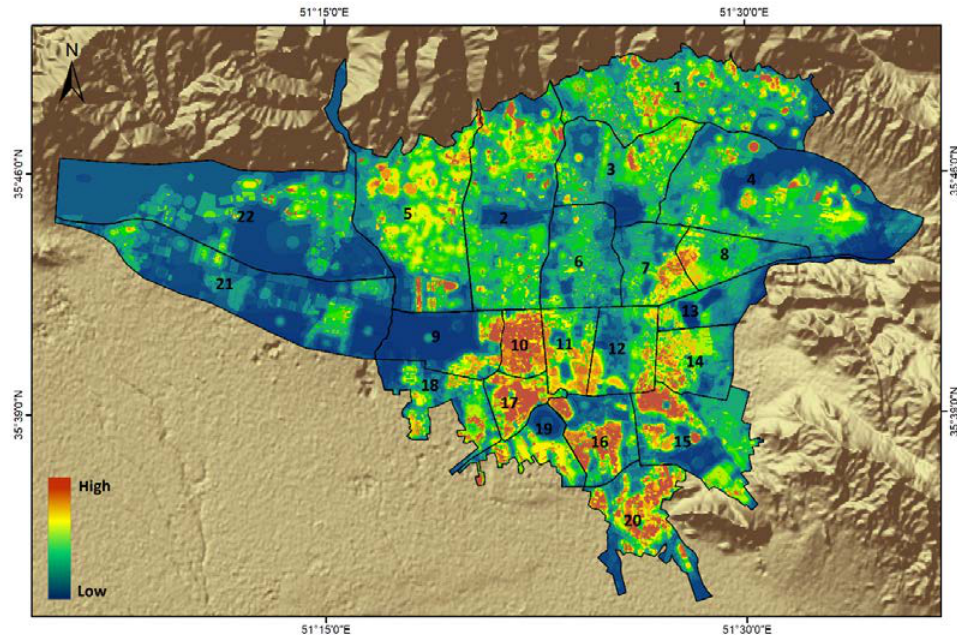
Figure 10. Earthquake risk map of Tehran.